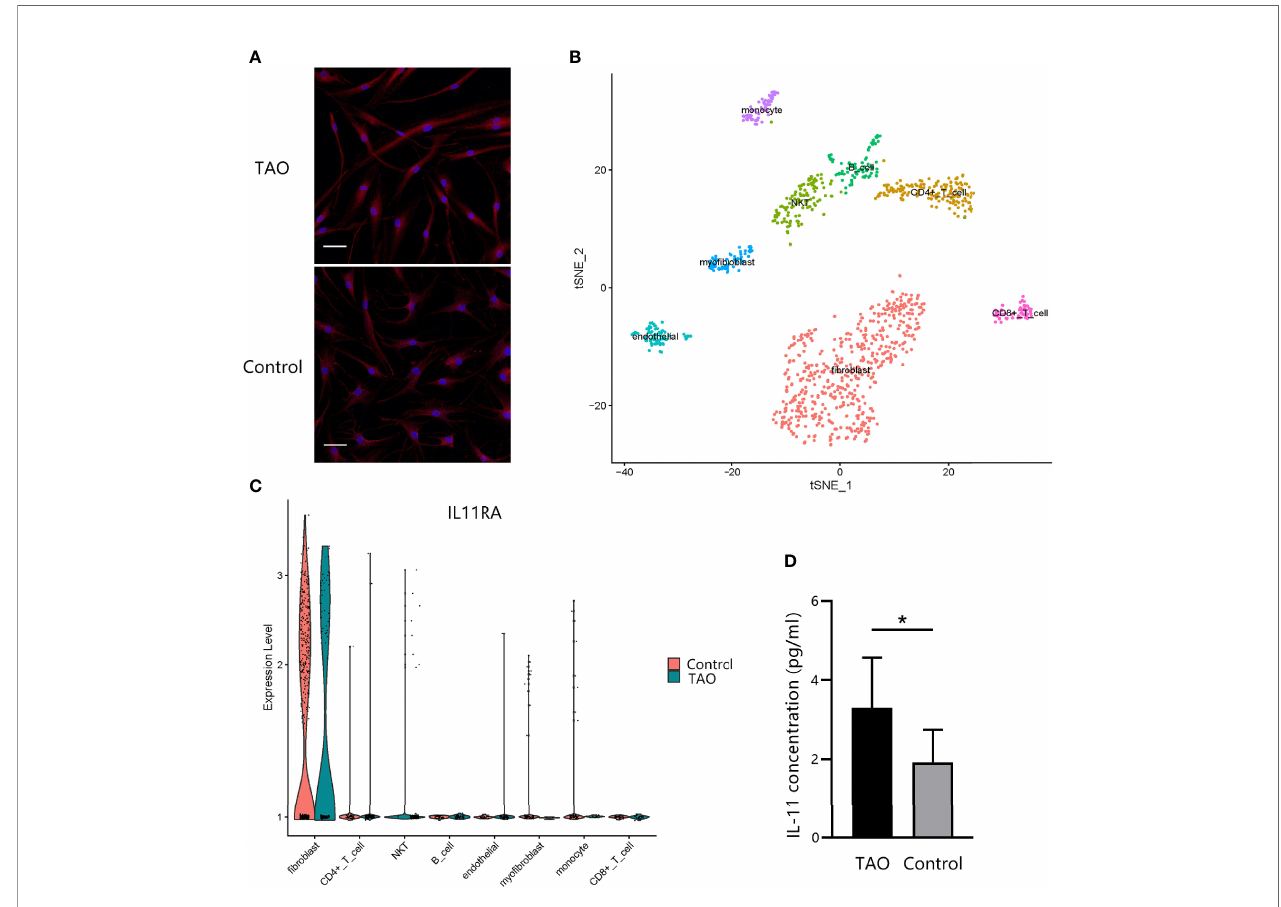
FIGURE 3 | IL-11R a and IL-11 are co-expressed in orbital fi broblasts (OFs). (A) The expression pro fi le of IL-11R a in OFs was demonstrated by immuno fl uorescence staining. Cells were photographed under a confocal microscope (200×). Scale bar, 50 m m. (B) Visualization of eight major classes of cells in orbital connective tissues by single-cell sequencing. The integrated single-cell transcriptome pro fi ling of one patient with thyroid-associated ophthalmopathy (TAO) and one control were visualized using a t-distributed stochastic neighbor embedding (t-SNE) plot. Each point represents one cell. (C) Comparation of differential